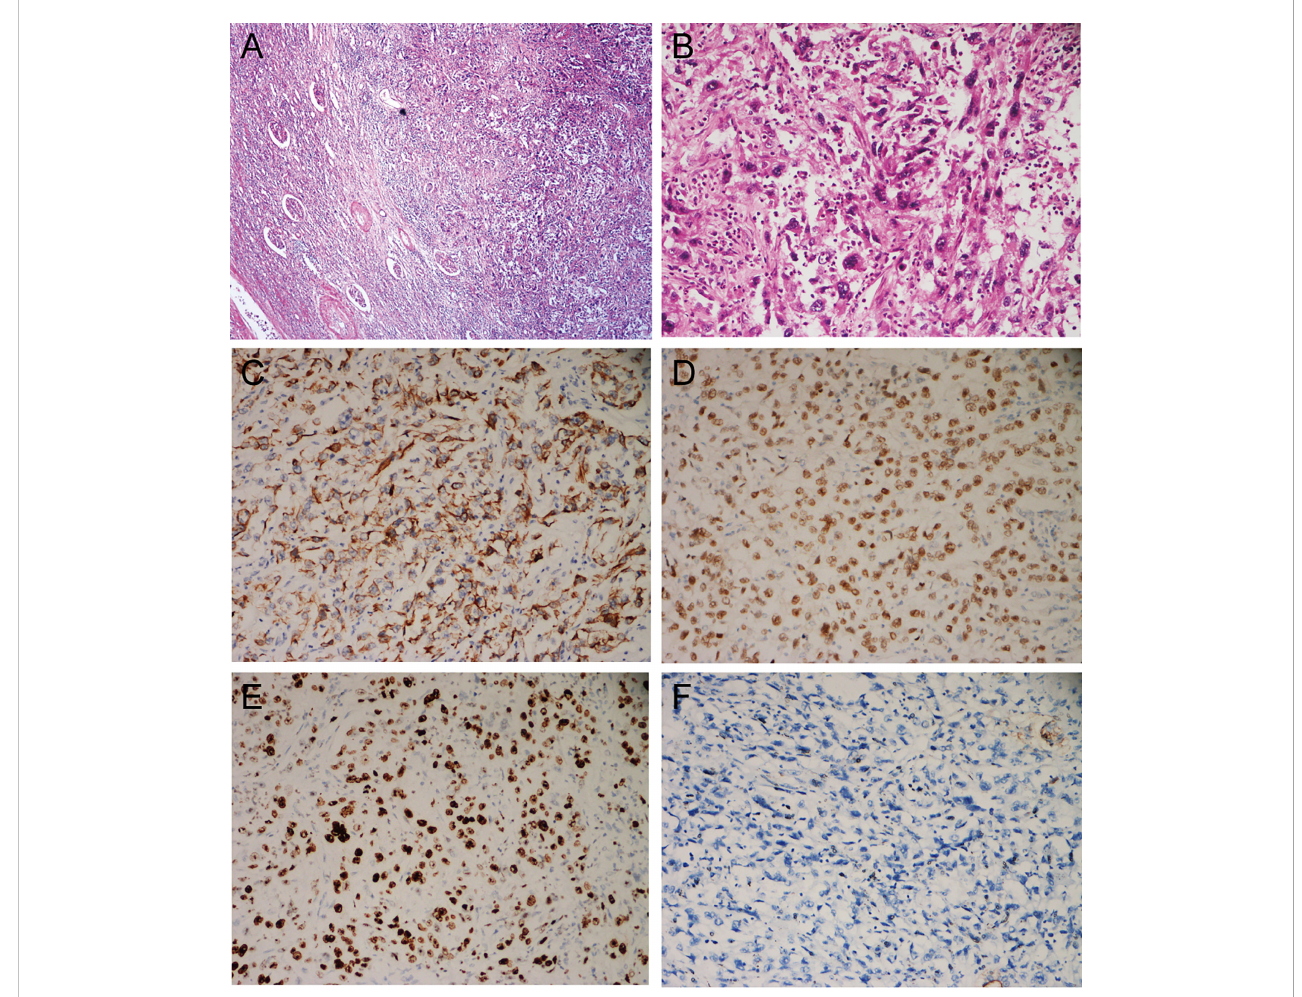
FIGURE 4 Histological and immunohistochemical features. (A) HE, ×40. Microscopically, the boundary of the tumor is poorly de fi ned and invades the renal parenchyma, with remnants of renal tubules and glomeruli visible in the periphery; (B) HE, ×200. The main bodies of the tumor cells are arranged in bundles, with obvious necrosis and in fl ammatory cell in fi ltration; some of the tumor cells are spindle-shaped, some are square or columnar, with a high degree of heterogeneity, high nucleoplasm ratio, obvious nucleoli, and the presence of giant tumor cells; (C) CK7 (+); (D) P63 (+); (E) GATA3 (+); (F) EMA (-).